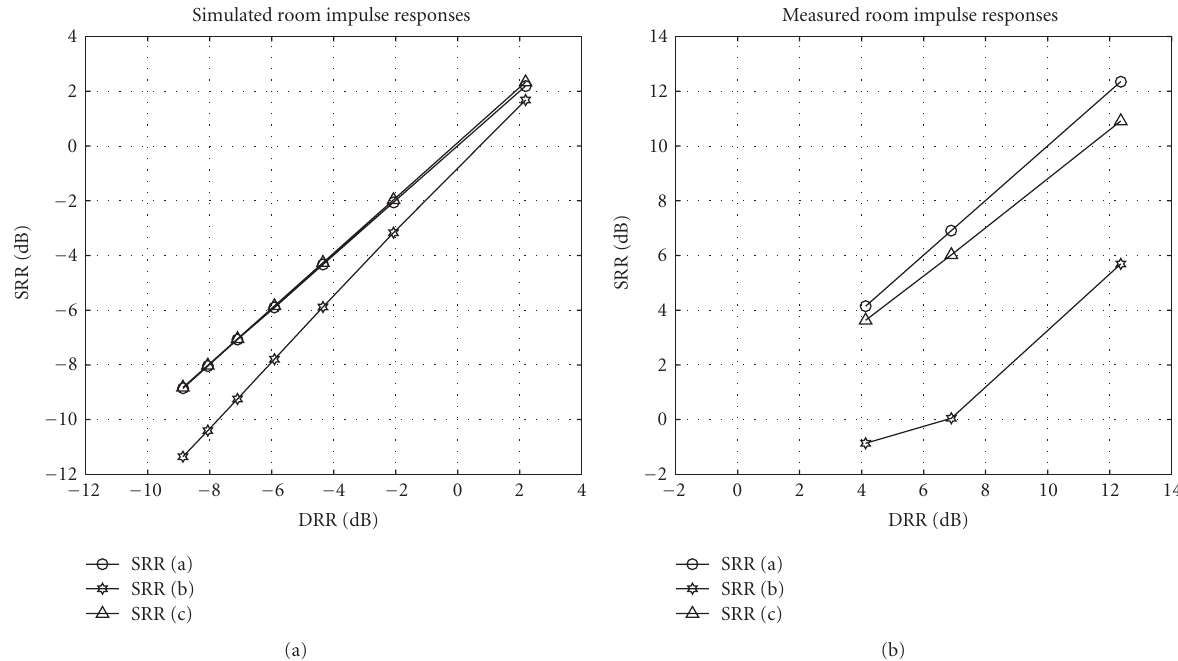
Figure 1: Comparison of DRR and SRR for (a) white Gaussian noise input, (b) speech input, and (c) prewhitened speech input, with simulated impulse responses (left) and mesured impulse responses